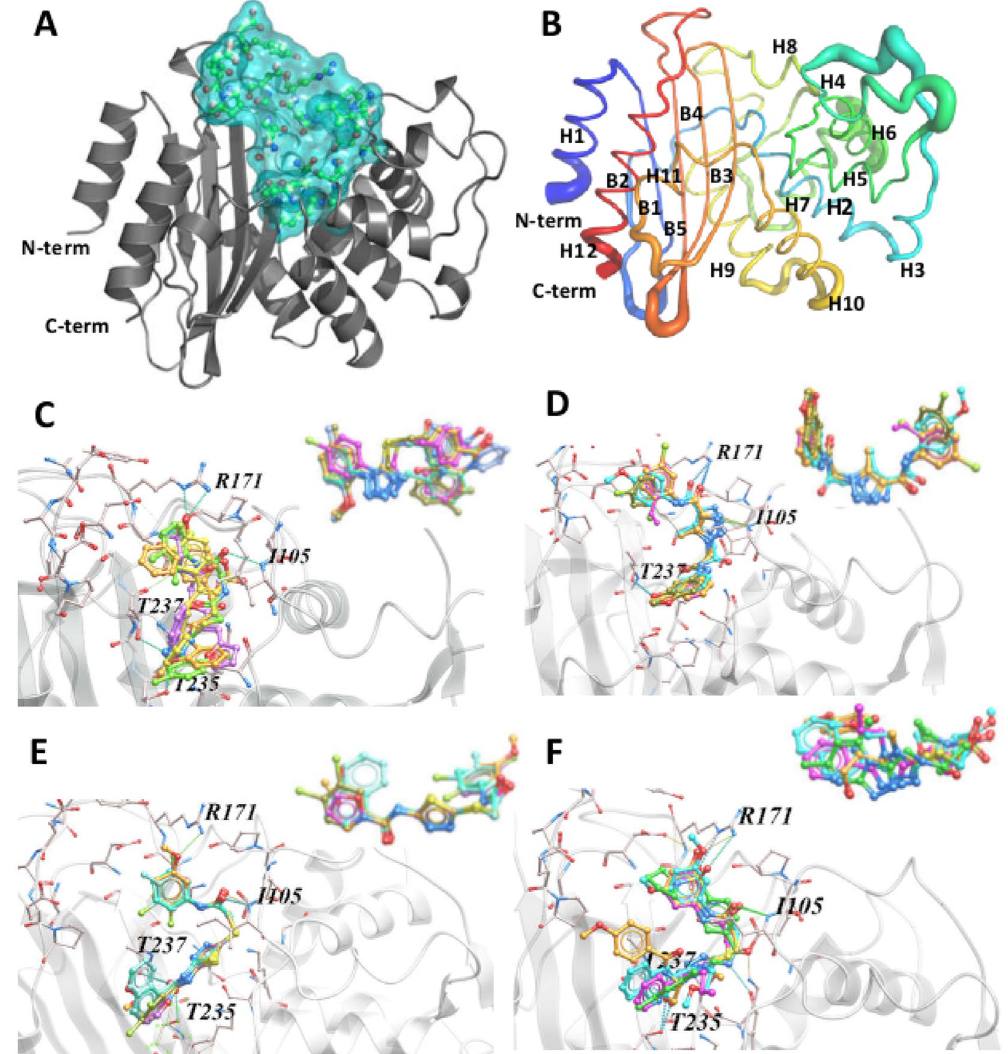
Figure 2. Virtual ligand screening and chemical clustering of compounds. ( A ) The crystal structure of BlaC with the residues defined as receptor displayed as sticks and the pocket formed by them displayed as cyan surface. ( B ) The crystal structure 2GDN in putty representation with the thickness depicting the B-factor and colored from blue (N terminus) to red (C terminus). The secondary structure features have been labelled with H1 through H12 representing the α -helices and B1 through B4 representing the β -sheets. ( C – F ) The highest scoring compounds of the four main chemical families identified by virtual ligand screening i . e . tetrazoles, 1-2-3-triazoles, thiadiazoles and 1,3,4-triazoles docked into the active site of ß-lactamase respectively. The inset shows the overlay of the compounds to emphasize the similarity in the docking poses of the compounds belonging to one